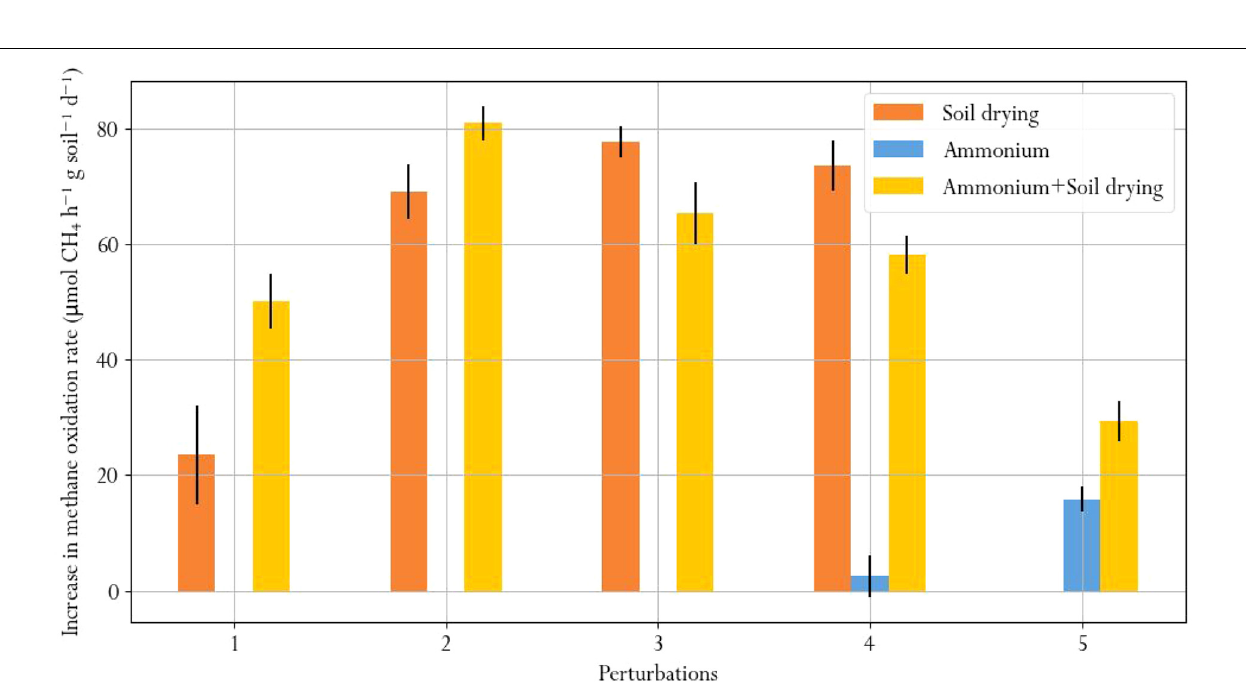
Frontiers in Microbiology |